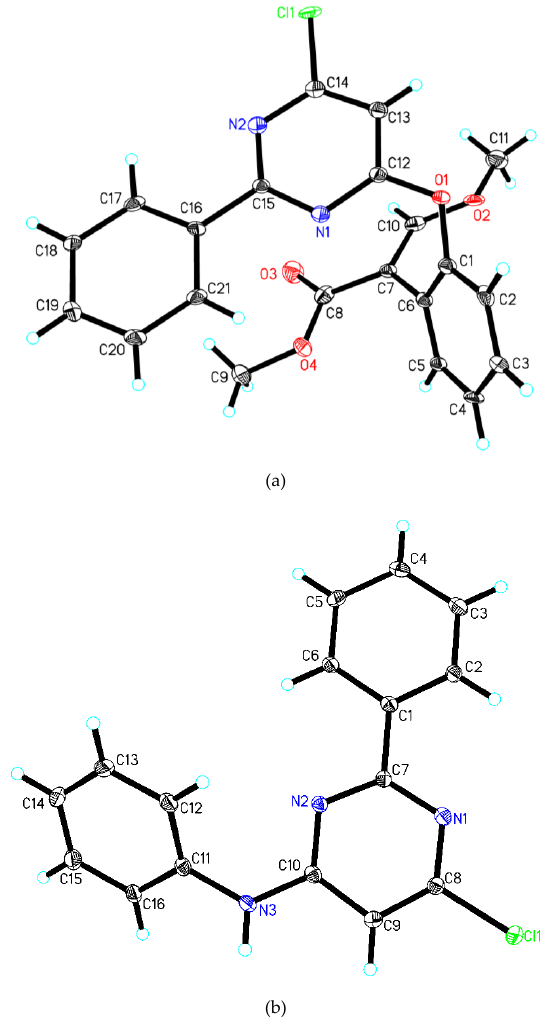
Figure 2. Crystal structure of compound 6 (2a ) and 7 (2 b ).